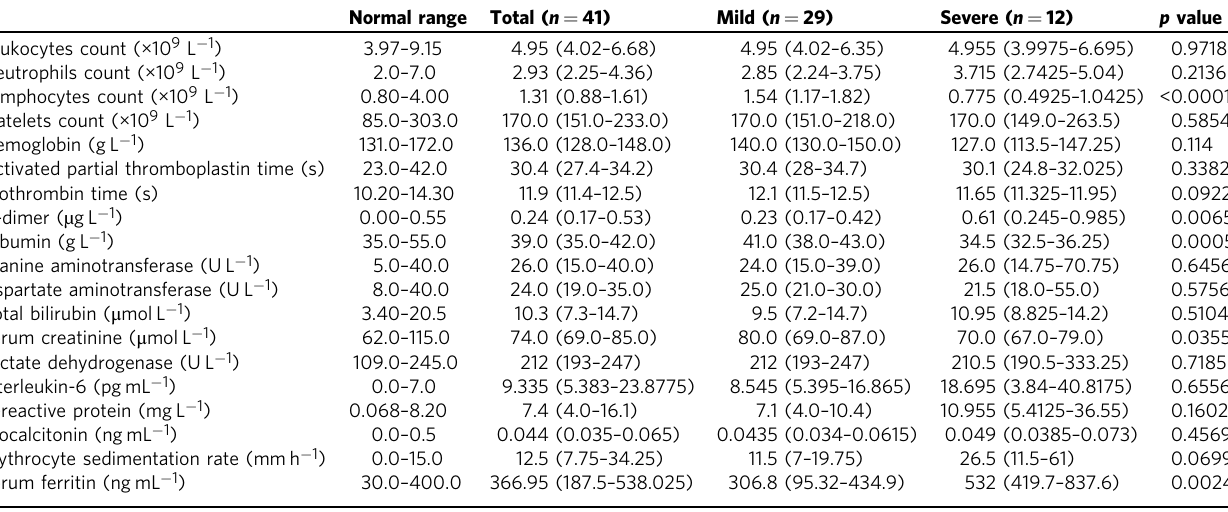
Table 2 Laboratory fi ndings of hospitalized patients infected with SARS-CoV-2.